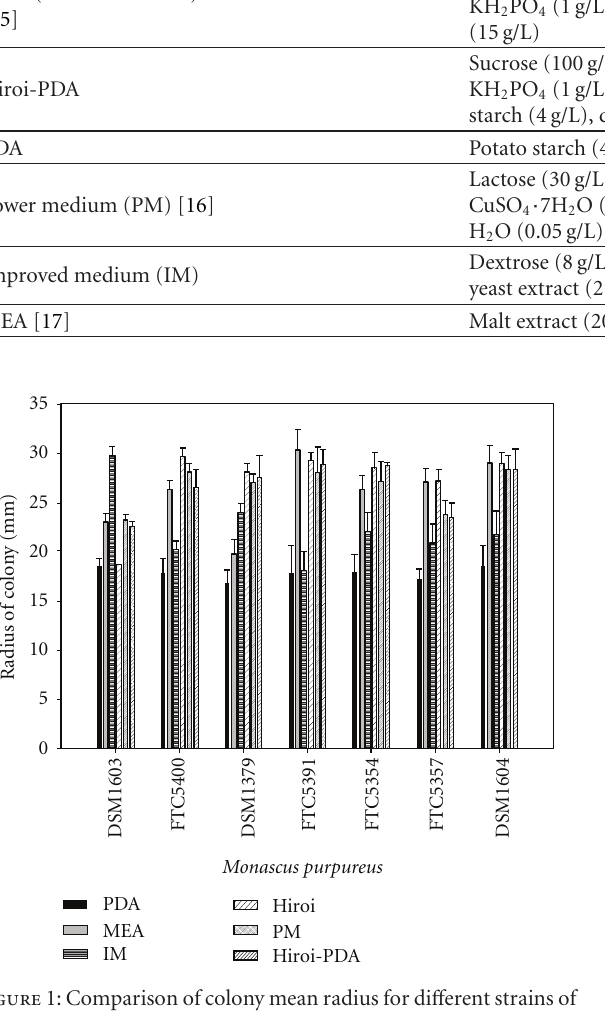
Table 1: Medium formulations tested in this study for the improvement of growth and sporulation of various strains of M. purpureus. Hiroi (sucrose medium)